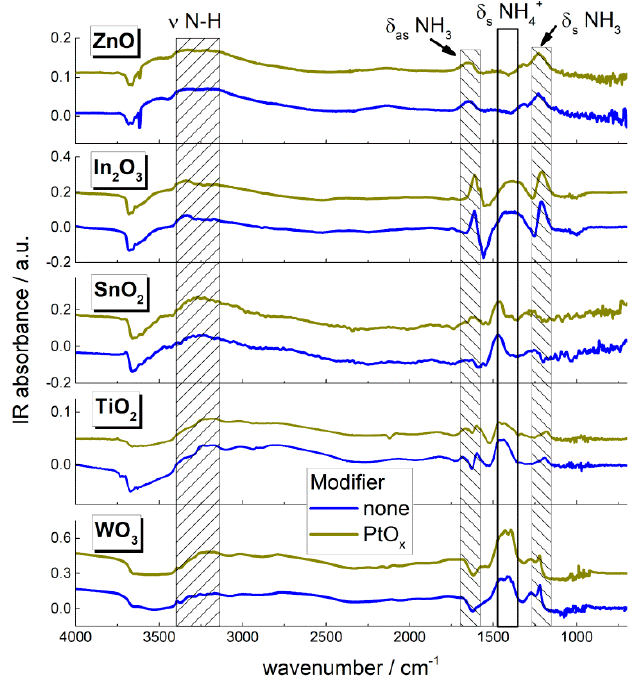
Figure 5. DRIFT spectra of pristine and PtO x − modified MOS exposed to 200 ppm NH 3 at room temperature for 1 h. Positions of stretching ( ν N-H) and symmetric ( δ s ) and asymmetric ( δ as ) vibrations of adsorbed NH 3 and NH 4+ species are shown.